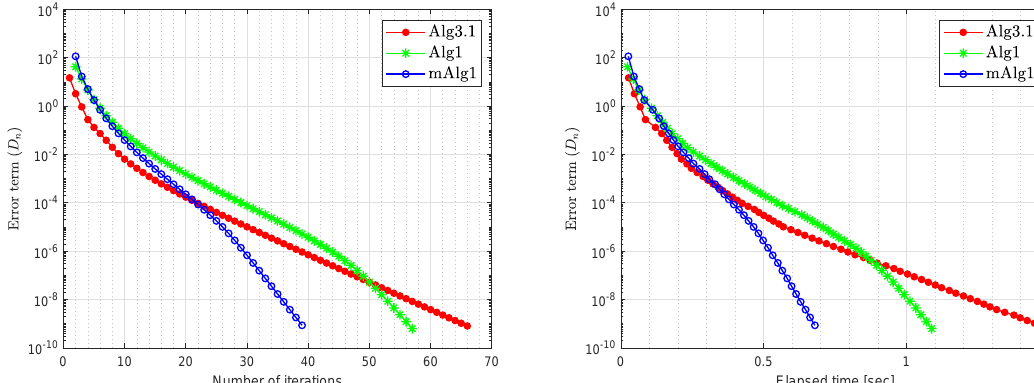
Figure 7. Example 1: Algorithm 1 (mAlg1) numerical comparison with Algorithm 3.1 (Alg3.1) in [39] and Algorithm 1 (Alg1) in [38] while m = 200.